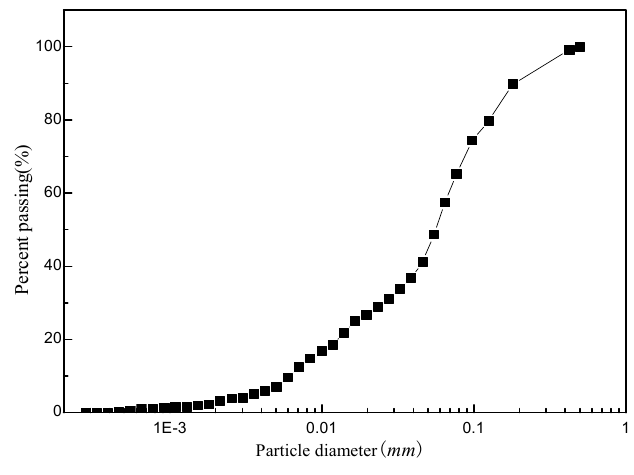
Figure 2. Grain-size distributions of the tailings.